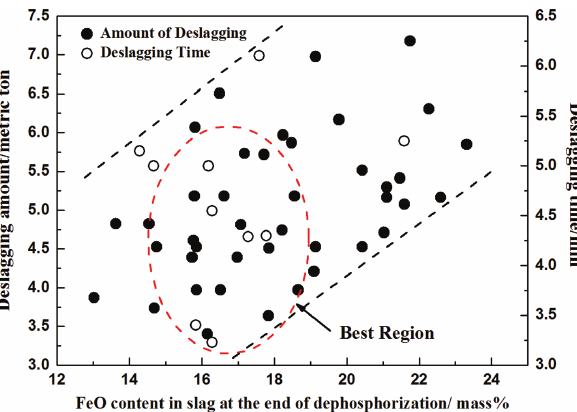
Figure 10: Relationship between (FeO) at the end of dephosphori- zation and deslagging amount and time.